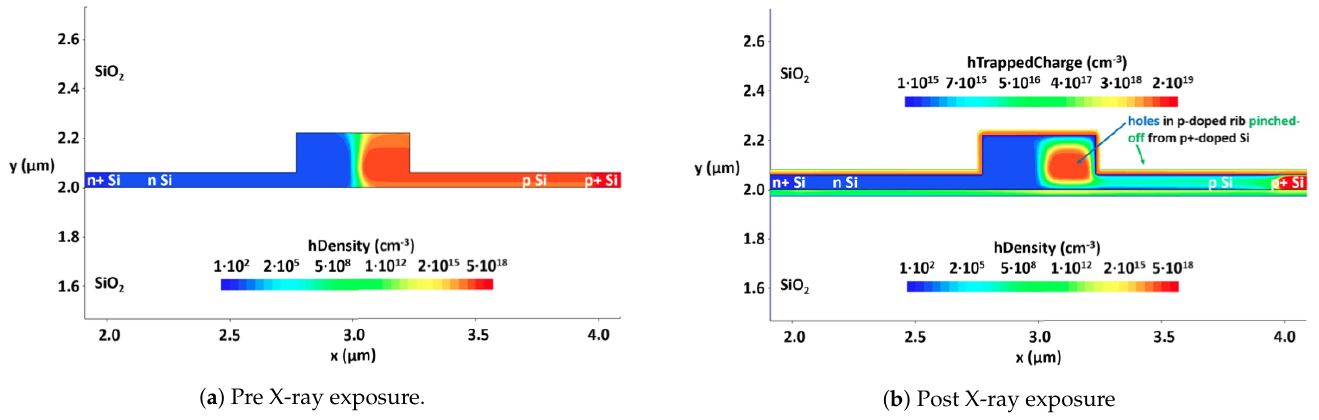
Figure 12. Simulation results showing ( a ) pre and ( b ) post X-ray exposure of a phase shifter used in an MZM. The pinch-off effect can be seen with the depletion of the carriers post radiation exposure (after